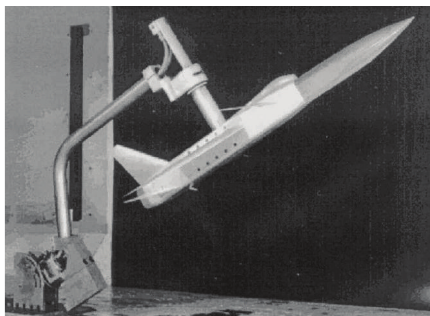
Figure 21: Photograph of the 2-DOF rig in the University of Cambridge [112].